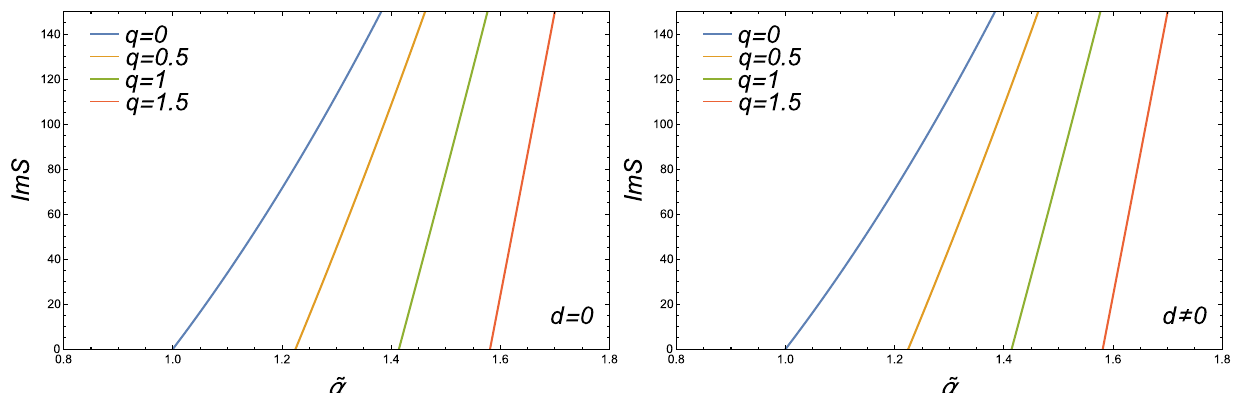
Fig. 9 The imaginary part of the effective action as a function of ˜ α = E / E c ( 0 ) in the D0–D4 background. The behavior of Im S is almost not affected by the value of d . We have set b =